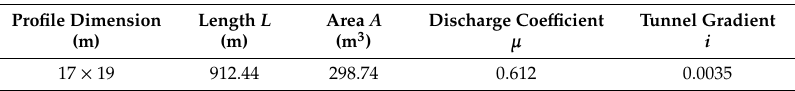
Table 2. Diversion Tunnel